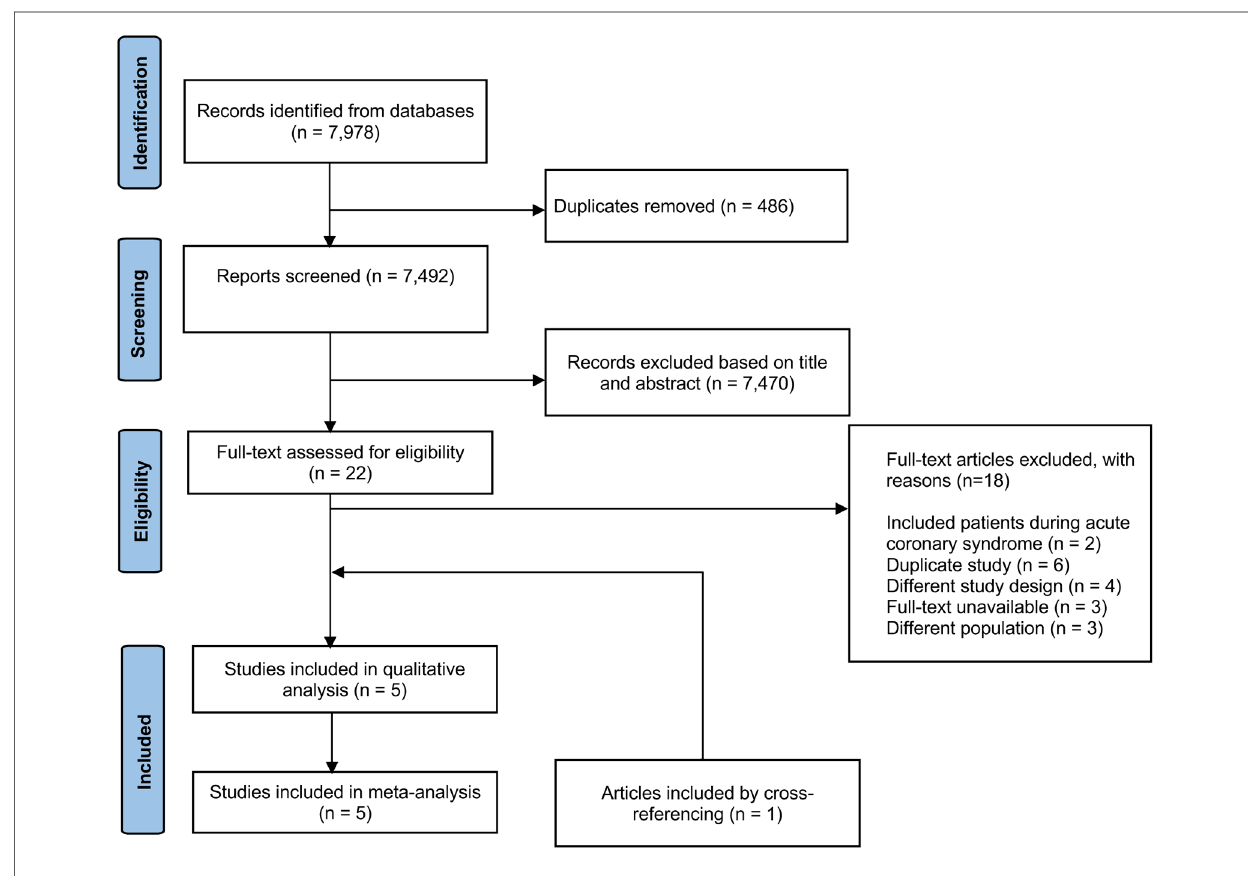
FIGURE 1 PRISMA fl owchart of articles included in network meta-analysis. From 7,492 unique articles, we screened titles and abstracts and excluded 7,470 articles that did not meet inclusion criteria. The full-text of eligible articles ( n =22), including an article included by cross-referencing, was reviewed using inclusion and exclusion criteria to identify articles for data extraction ( n =5). All stages were conducted independently by 2